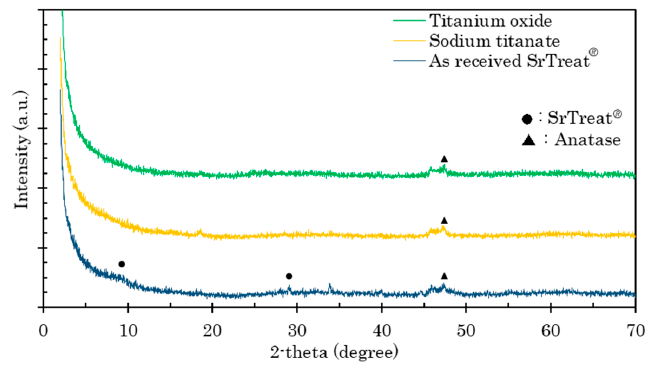
Figure 1. X-ray diffractometry (XRD) patterns of the samples used in the present study. Table 1. Results of energy dispersive X-ray (EDX) analysis on the titanates in the present study (mol %) 1 . Titanate Ti